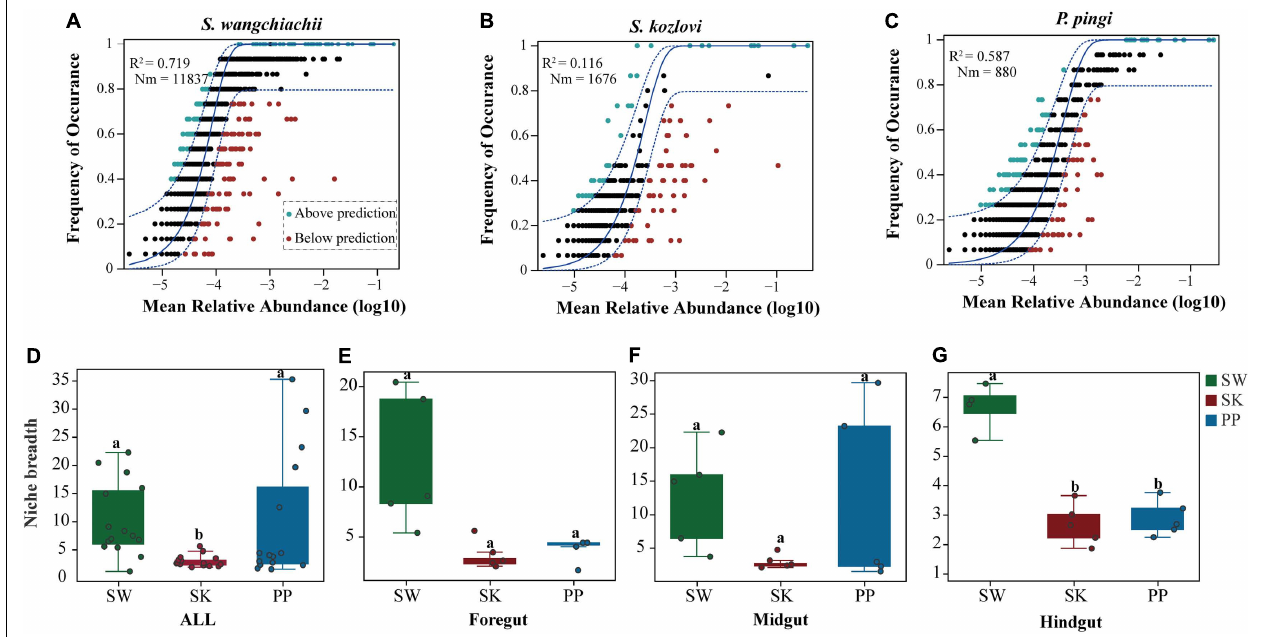
FIGURE 7 | Community assembly process measurements using the niche width and neutral community model (NCM) of the three cold-water fishes. (A–C) Predicted occurrence frequencies of S. wangchiachii , S. kozlovi , and P. pingi gut microbes, respectively. The solid blue line represents the best fit to the NCM, and the dashed blue line indicates 95% confidence intervals around the model prediction. The green point indicates OTUs that occur more frequently than predicted by the NCM, and the red point represents OTUs that occur less frequently than predicted by the model. R 2 represents the fit to this model, and Nm represents the metacommunity size times immigration. (D–G) The relative abundance of the niche width of the three cold-water fishes. SW, S. wangchiachii ; SK, S. kozlovi ; PP, P.